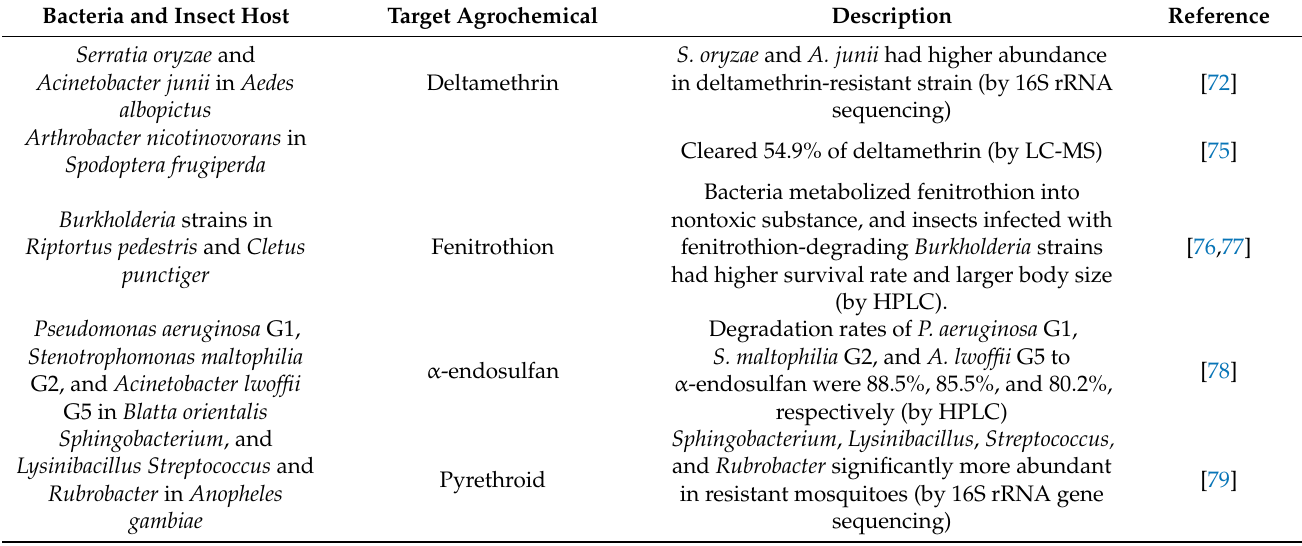
Table 2. Symbiont-mediated insect resistance to